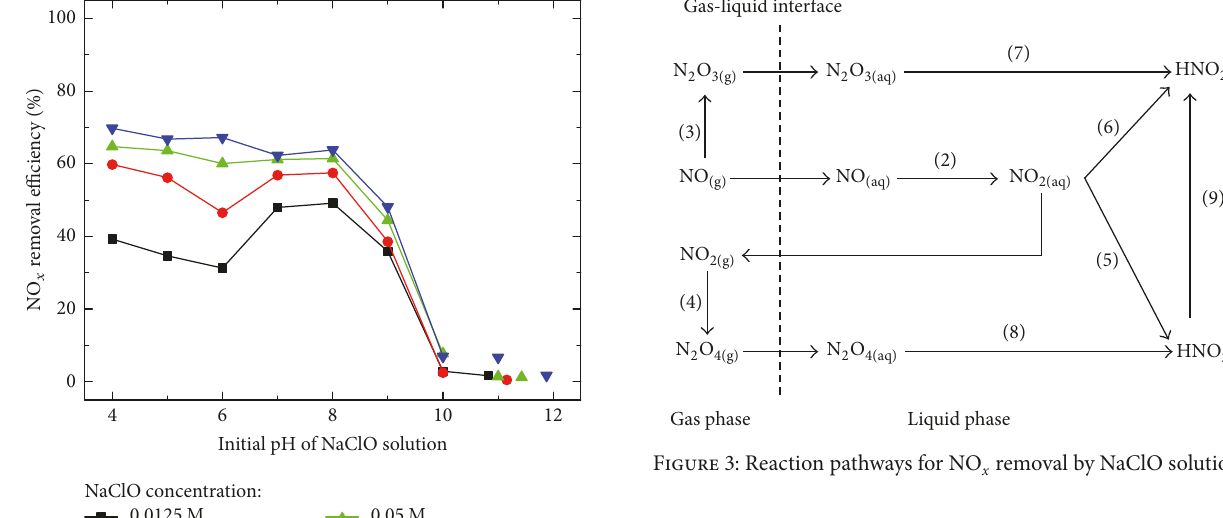
Figure 3: Reaction pathways for NO